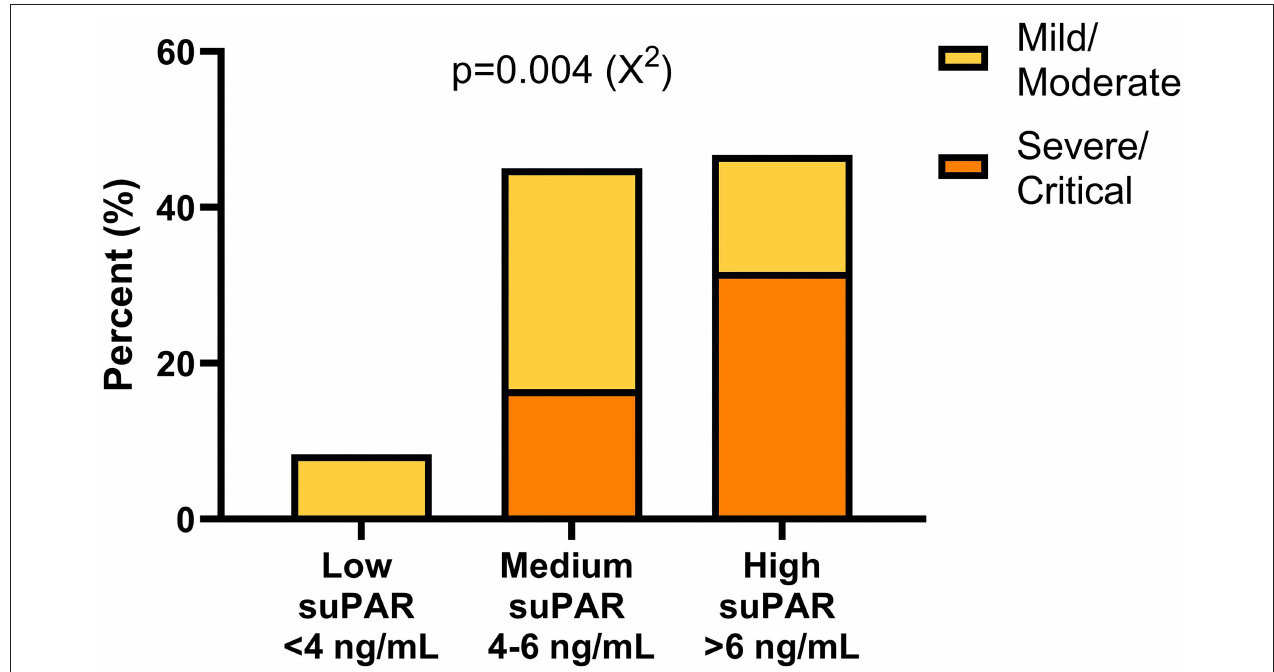
FIGURE 5 | Frequencies of patients with mild/moderate and severe/critical illness within different suPAR level intervals. Patients were stratified into three suPAR level groups according to manufacturer’s recommendations. A χ 2 test revealed asymmetric distribution of patients with different disease severity. suPAR, soluble urokinase plasminogen activator